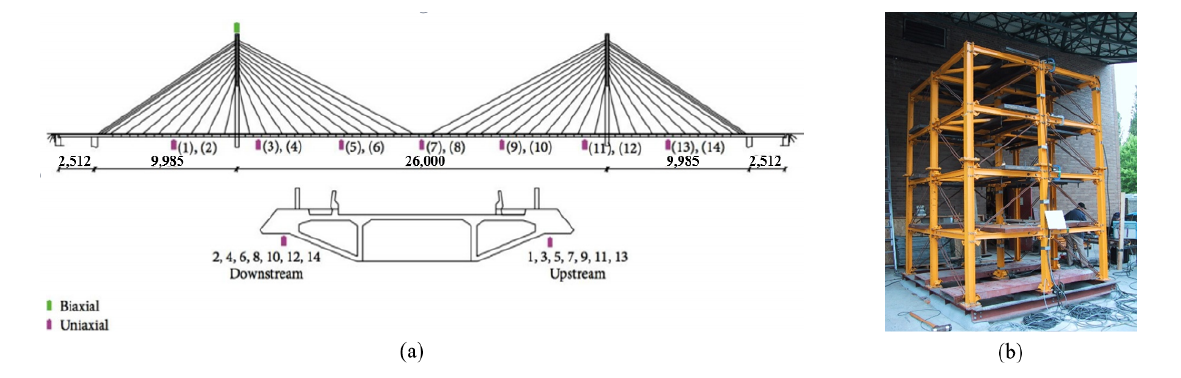
Figure 6. ( a ) Arrangement of accelerometers on Yonghe Bridge; ( b ) diagram of ASCE benchmark structural